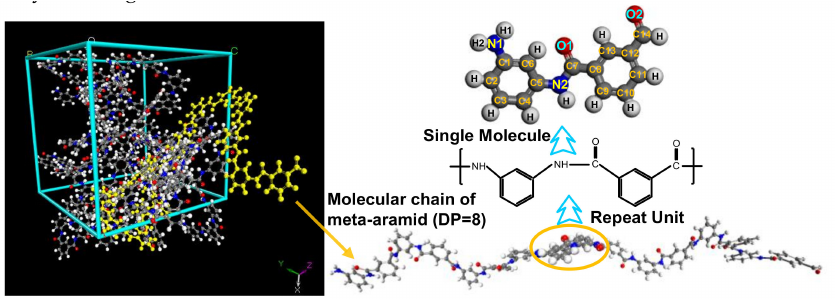
Figure 3. Model of the amorphous area of meta-aramid